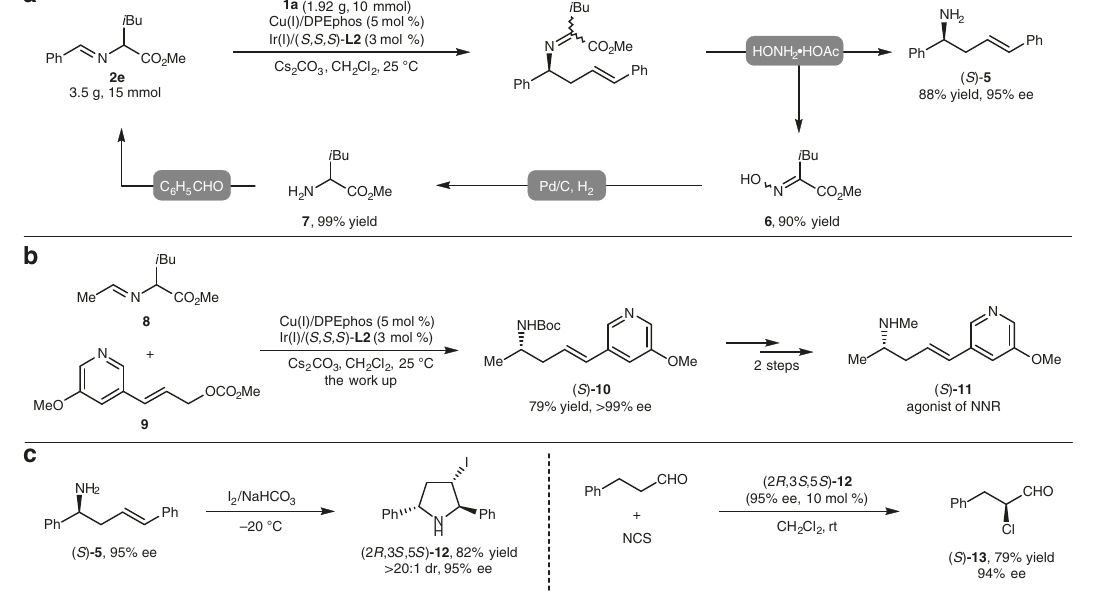
Fig. 9 Gram Scale and Synthetic Applications. a Synthesis of ( S )- 5 in gram-scale and recycling of by-product. b Synthesis of the key intermediate of agonist of NNR. c Transformation of ( S )- 5 to pyrolidine derivatives (2 R ,3 S ,5 S )- 12 and its application as organocatalyst in asymmetric α -chlorination of